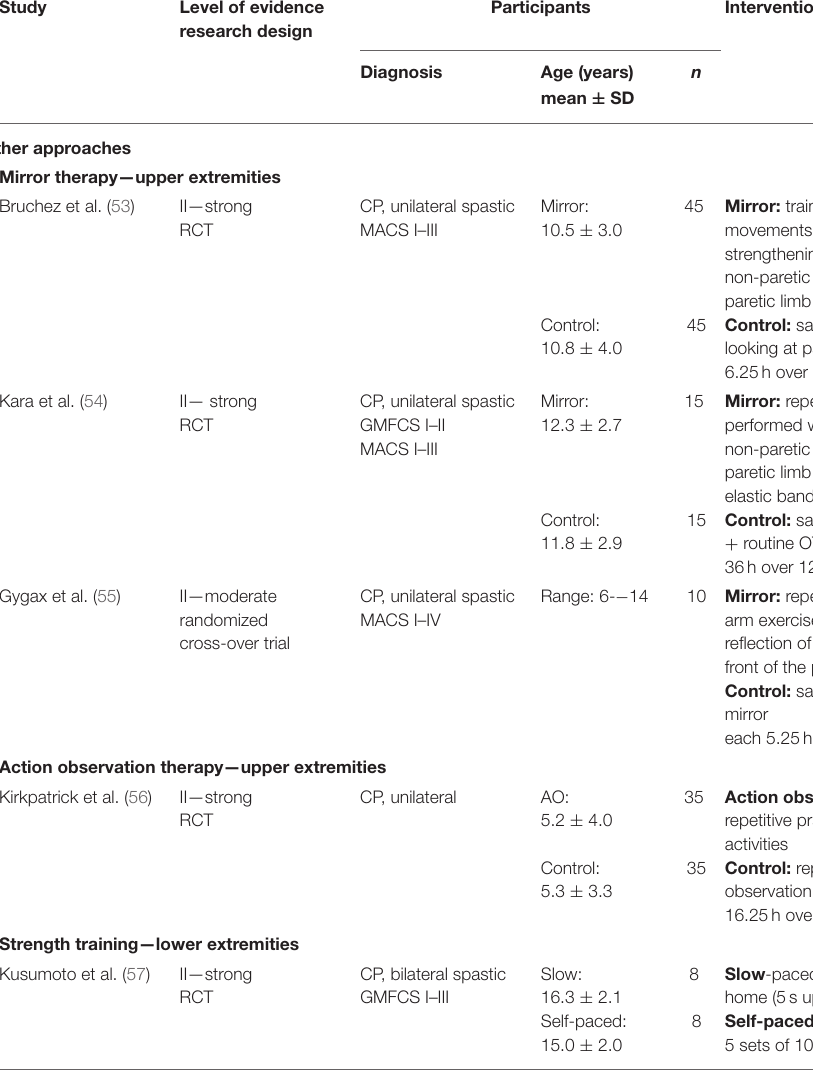
non-paretic hand in a mirror placed in front of the paretic limb + power and strength training with elastic band Control: same grasp exercises without a mirror